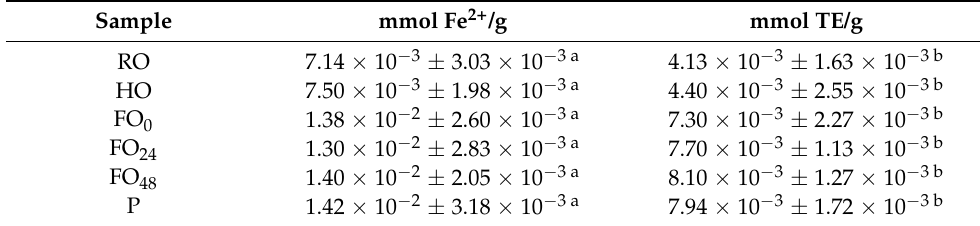
Table 2. FRAP values of raw, hydrolyzed, and fermented oatmeal samples (RO, HO, FO 0 , FO 24 , FO 48 , and P, respectively). Each result is shown as the mean value of a triplicate analysis and the corresponding standard deviations. Values marked with same lowercase letters in the same column are not significantly different ( p >